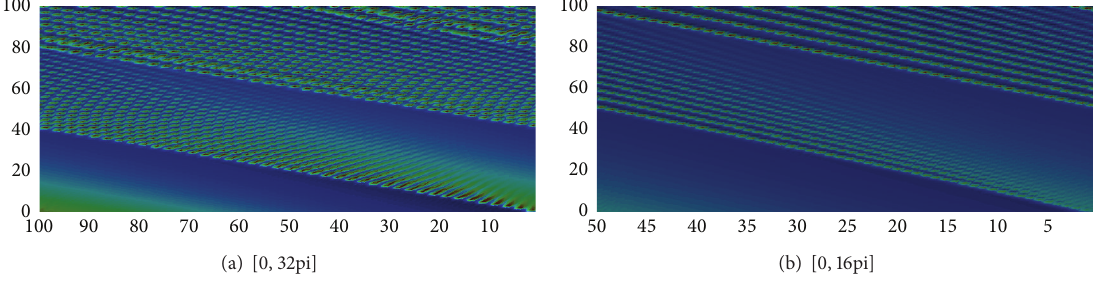
Figure 4: Time evolution for the hydrodynamics equation together with initial wave 𝑢 = tan (𝜃 + ] ) sech 2 (𝑥 − 𝑐𝑡) + tan (𝜃 + ] ) exp [𝑖𝑘(𝑥 − 𝑐𝑡)] , 𝜃 = 0.1 and ] = 1